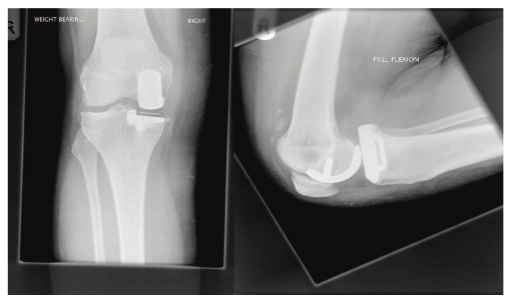
Figure 2: AP view and lateral view radiographs of the knee prior to replacing the mobile bearing.